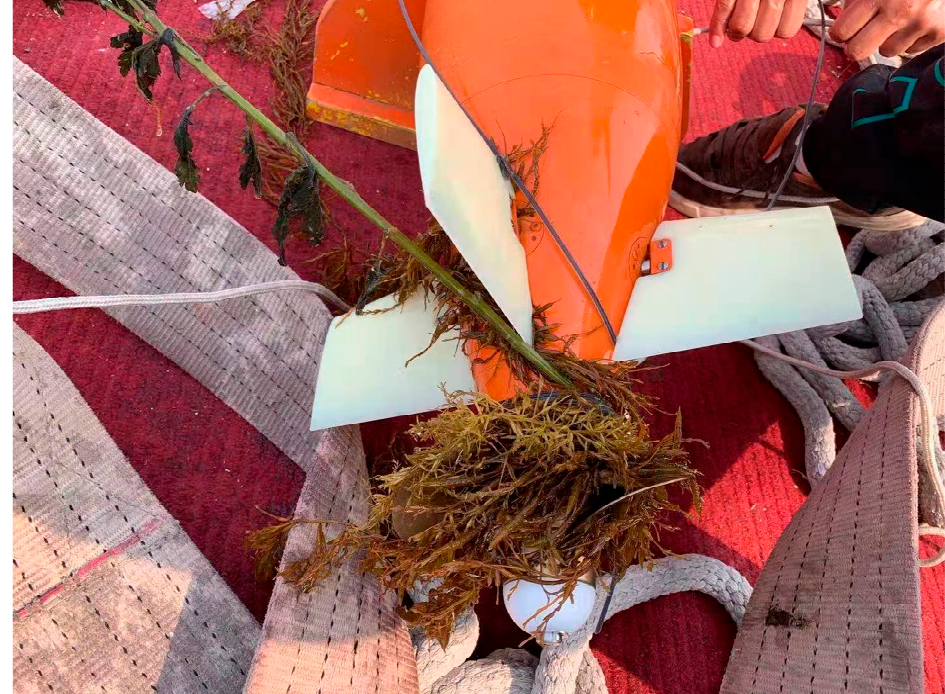
Figure 18. Thruster of the portable AUV blocked by weeds during the sea trial.